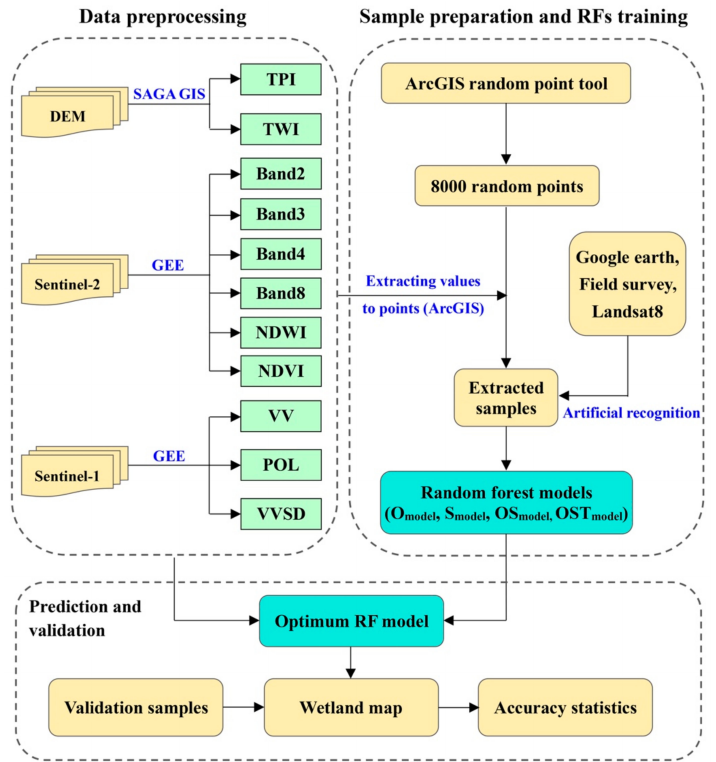
Figure 3. The workflow of the proposed coastal wetland